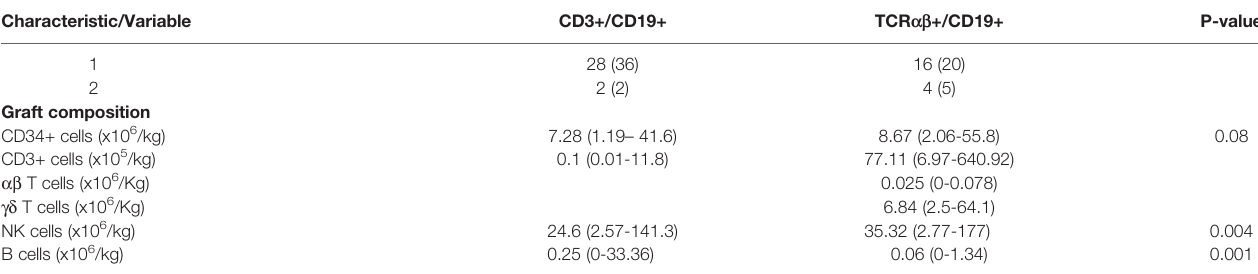
CMV,cytomegalovirus;KIR,Killer-cellIg-likeReceptor;MRD,MinimalResidualDisease;CR,CompleteRemission; TBF,Thiotepa,Busulfan,Fludarabine;Flu-Mel,Fludarabine,Melphalan; n.s, not signi fi cant. The bold values are the statistically signi fi cant